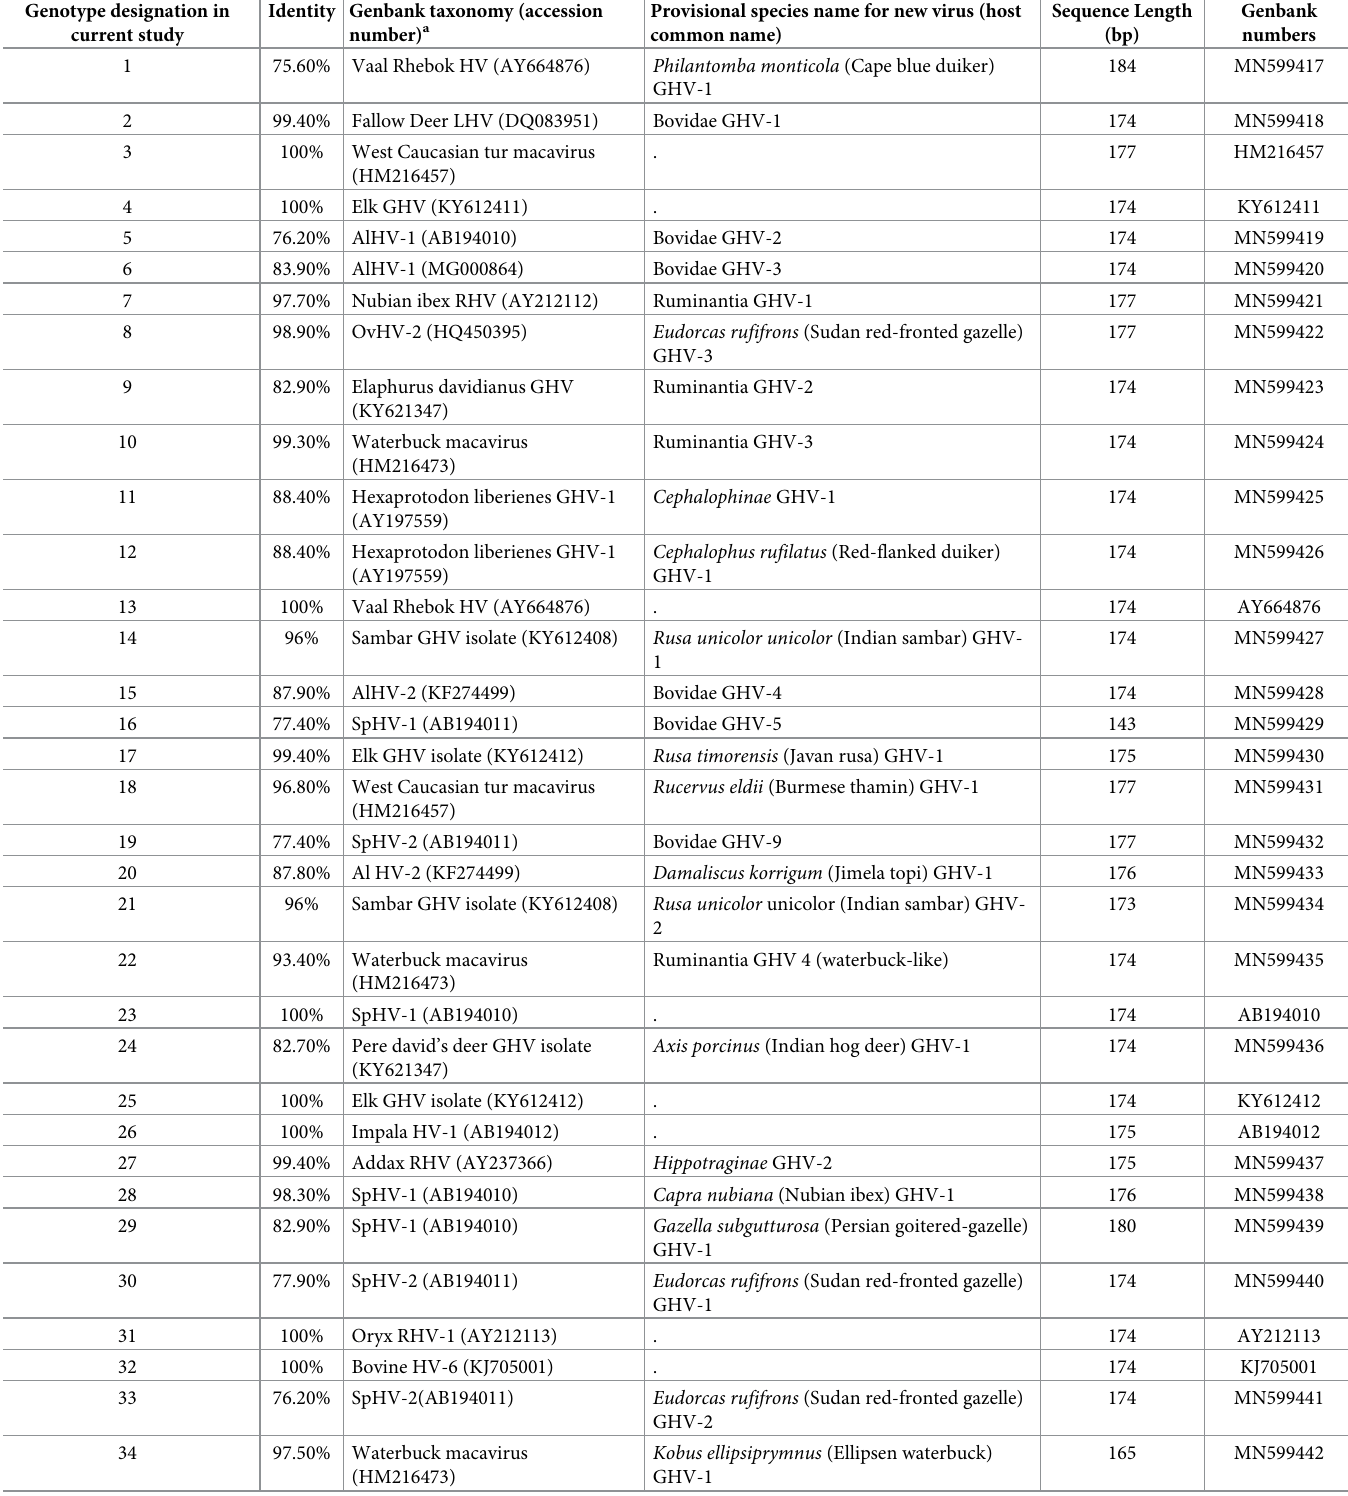
Table 3. Summary of DPOL genotype nucleotide BLAST